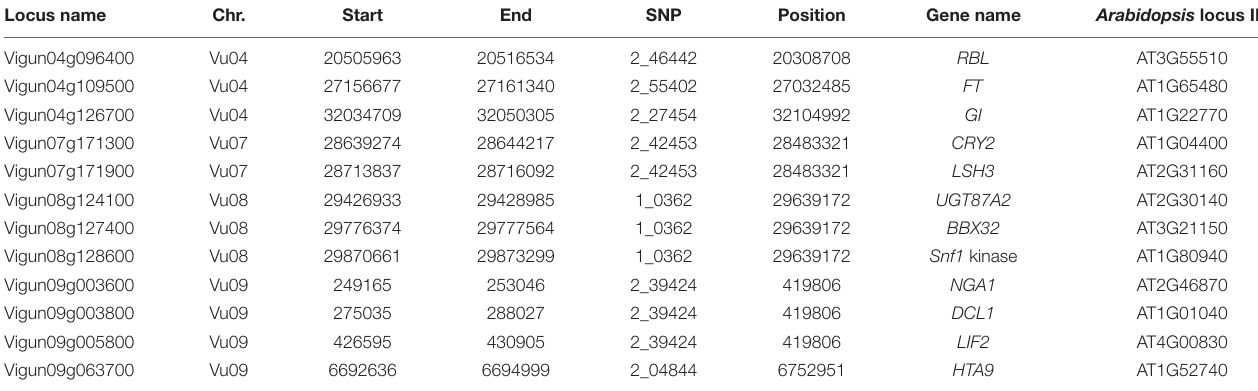
TABLE 3 | Genes related to flowering time that are within ± 270 kb of the significant SNPs. Locus name